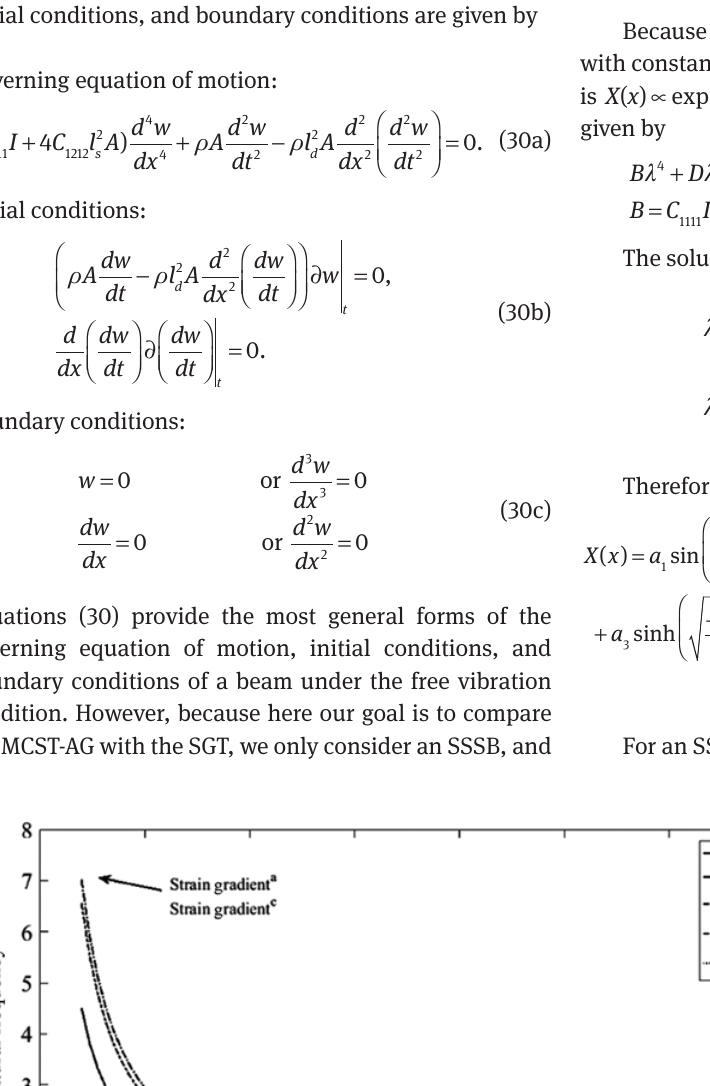
Figure 4: Normalized first natural frequency of an SSSB based on the strain-gradient theory and the MCST-AG, l each theory. The curves are normalized with respect to the first natural frequency according to the classical continuum mechanics. a, b, and c are from [8], [35], [3],